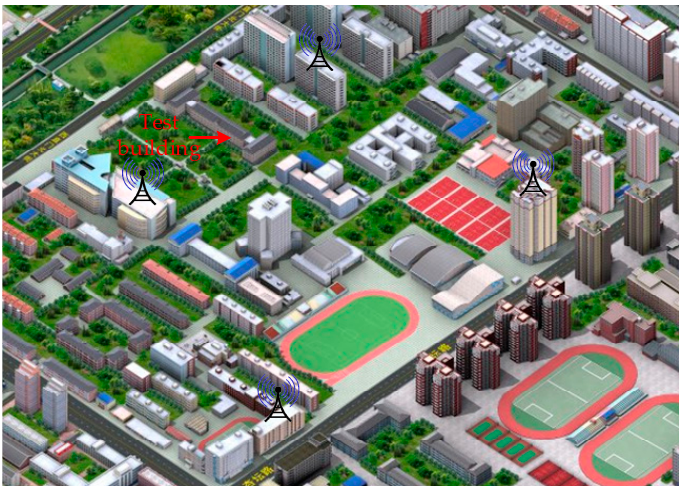
Figure 17. The positioning accuracy of MDBBS.